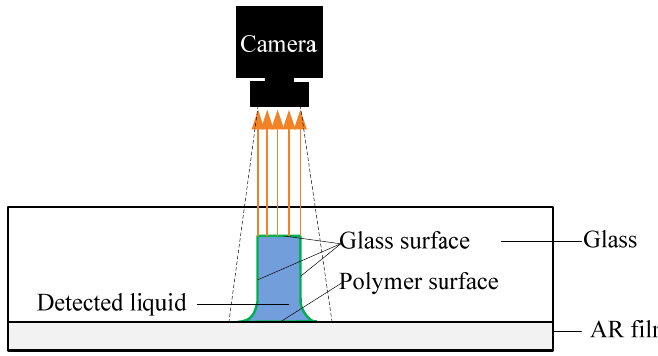
Figure 14. A typical testing diagram of the produced glass and anti ‐ reflection (AR) film chip.